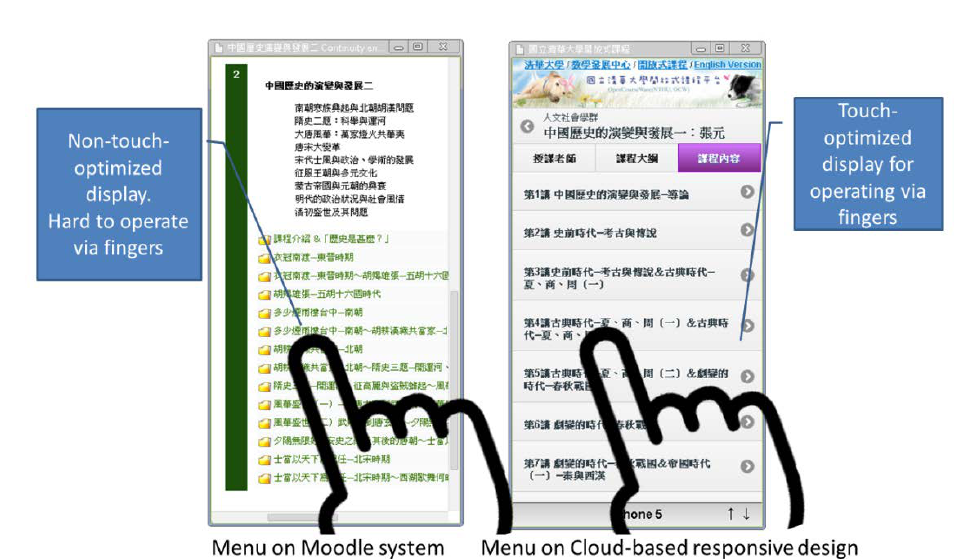
Figure 4 . Traditional menu interface (left) and touch-optimized interface (right)